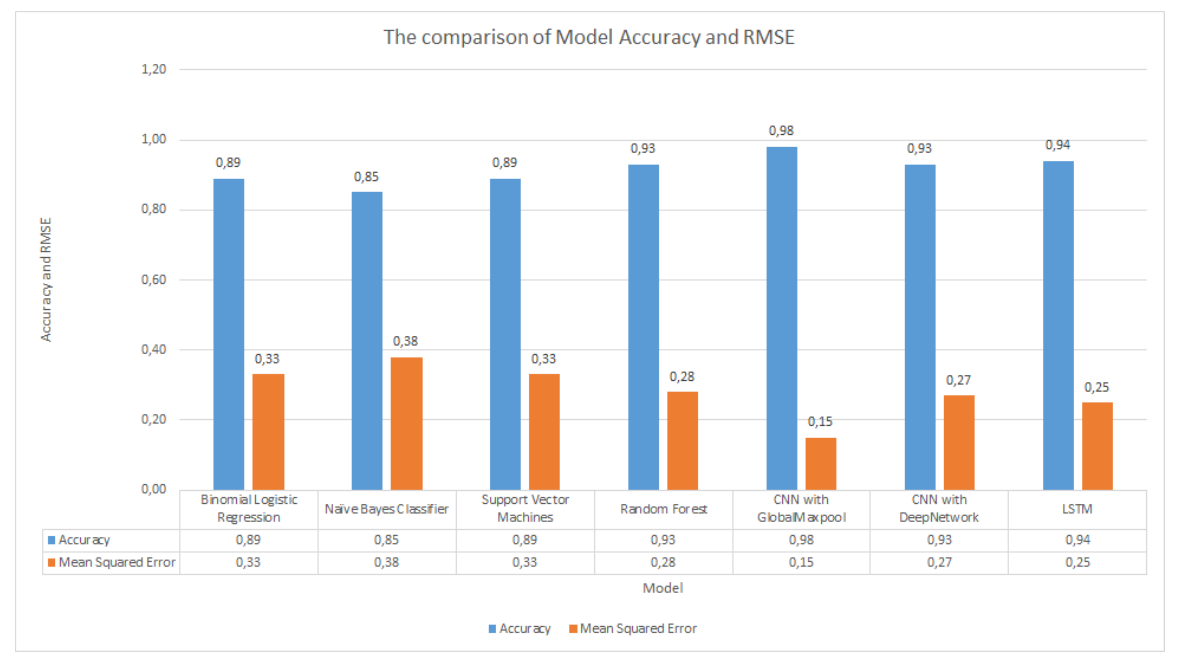
Figure 32. The comparison of model Accuracy and